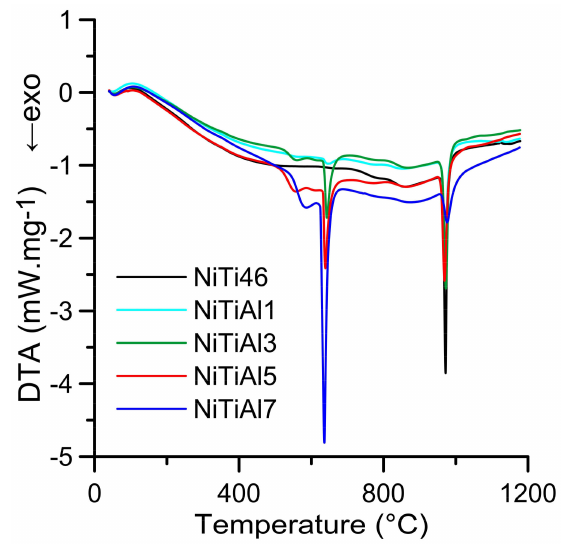
Figure 1. DTA heating curves of NiTi46 and NiTiAl1—-7 to 1200 ◦